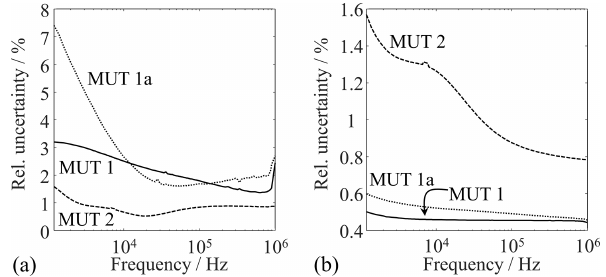
Figure 5. Uncertainty ellipses at a confidence level of 95% for sam- ples of new sand (MUT 1) at a frequency of 100kHz. (a) Measuring cell filled once and measured 20 times. (b) Measuring cell emptied and refilled 10 times and measured 20 times each.